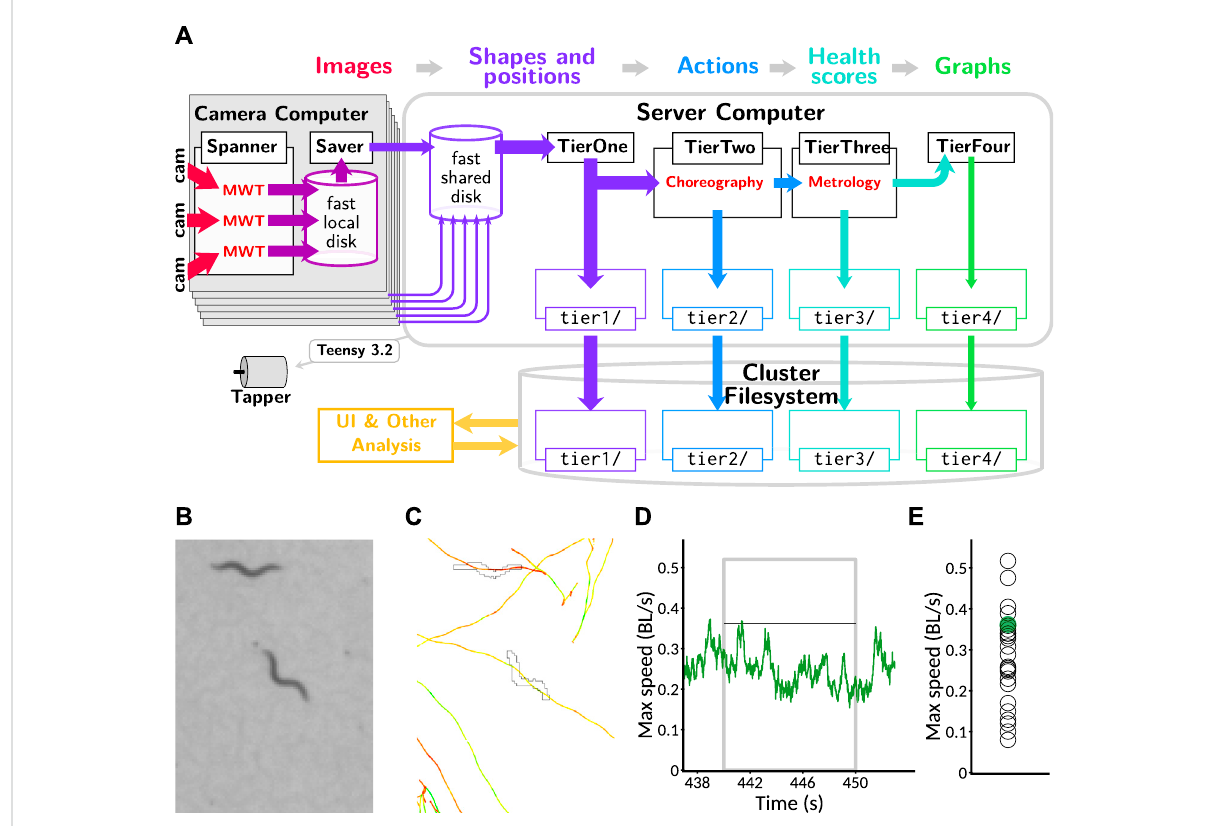
FIGURE 3 Data processing pipeline and data reduction. (A) Information fl ow within pipeline. Image data from cameras (red: 2.3 TB per session across 18platesimagedsimultaneously)areprocessedinrealtimewiththeMWTsoftwareintoanimalshapesandpositions(purple:1GBpersession).Thisis transmitted to a central server where the Choreography software is used to compute timecourses of behavioral parameters and actions, including speed (blue: 400 MB per session), from which per-animal health scores such as maximum speed in a time window are computed using the Metrology software (teal: 1 MB per session). Finally, this is collated into timecourses for visualization by averaging across animals at each timepoint (green: 10 kB persession).Allcategoriesofdata, except forthefull videofeeds which areprocessedlive,are backed upto acluster fi lesystem,which is accessible to the web server that runs the user interface (gold). (B) Portion of a raw image as captured by the Observatory. Image covers 3.4 × 4.68 mm. (C) Exampleofawormoutlineandpath,extractedfrom (B) withtheMWTandvisualizedwithChoreography.Outlinecorrespondingtothe image is shown; paths of animals ’ centroids are plotted for all times. Paths are colored according to movement speed: yellow is faster and red is slower. Scale as in (B) . (D) The speed of the centered animal in (C) over the “ aroused speed ” window (post-stimulation). Measurement window indicated by a gray box. Thin black line indicates the maximum speed measured from this animal (after a 5-point median fi lter). (E) Maximum speed for the animal of interest (green dot) and others on the plate (open black circles) as measured by